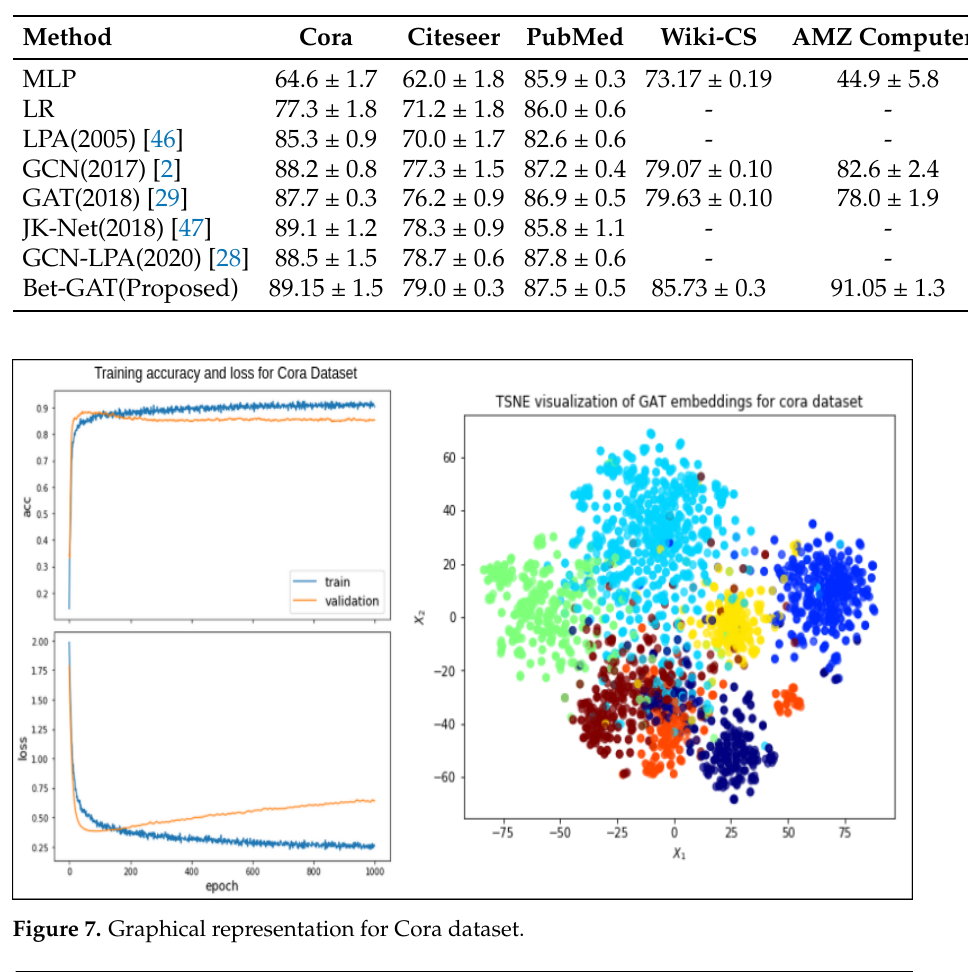
Table 2. Experimental results.